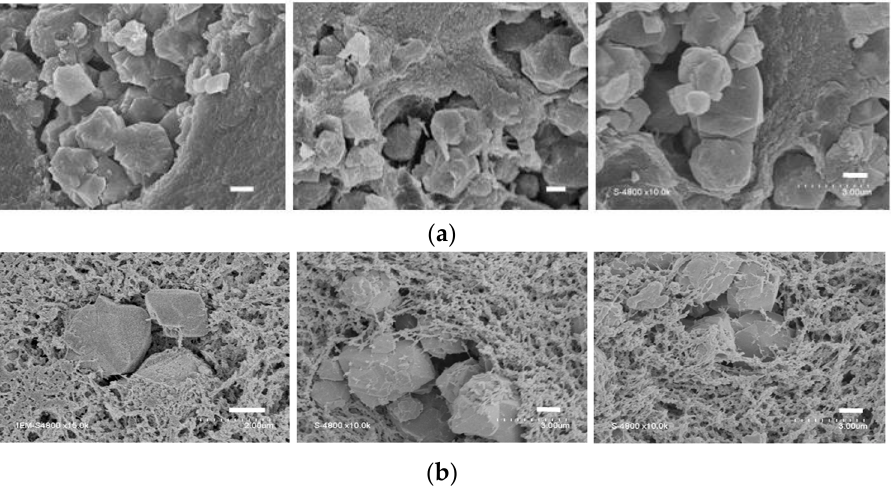
Figure 5. Scanning electron micrographs of xerogels ( a ) and aerogels ( b ) of composites A, B, and C from left to right. Scale bars 1 μ m.